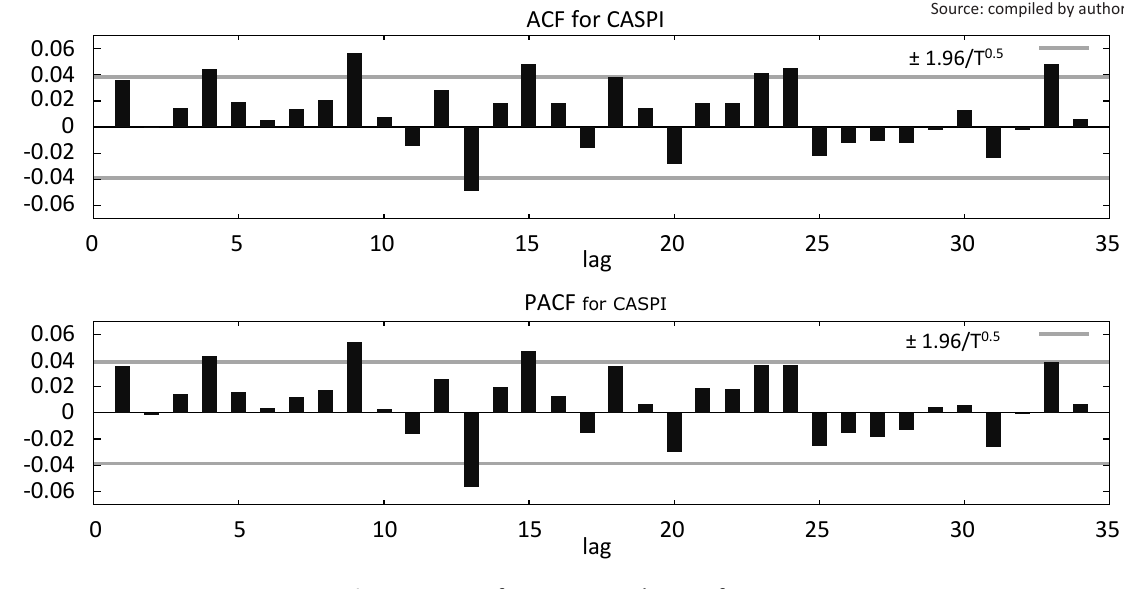
Figure 4. ACF for CASPI and PACF for CASPI Table 2. Estimation results of the ARFIMA models Source: authors’ calculation. ARFIMA-FIGARCH: BBM’s method ARFIMA-FIAPARCH: BBM’s method (Student distribution) (Student